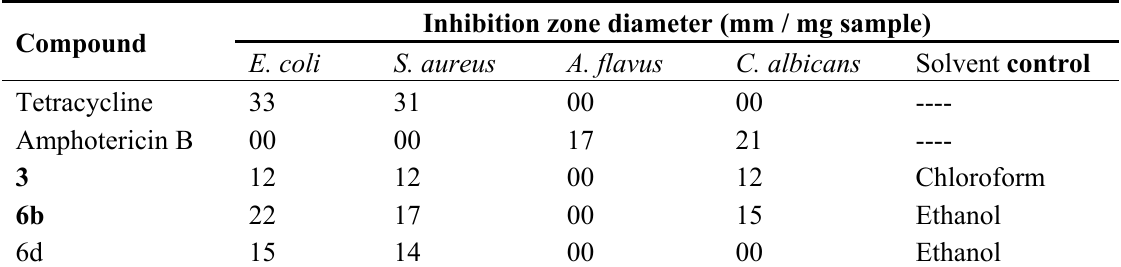
Table 1. In vivo antimicrobial activity by agar diffusion method of tested compounds.